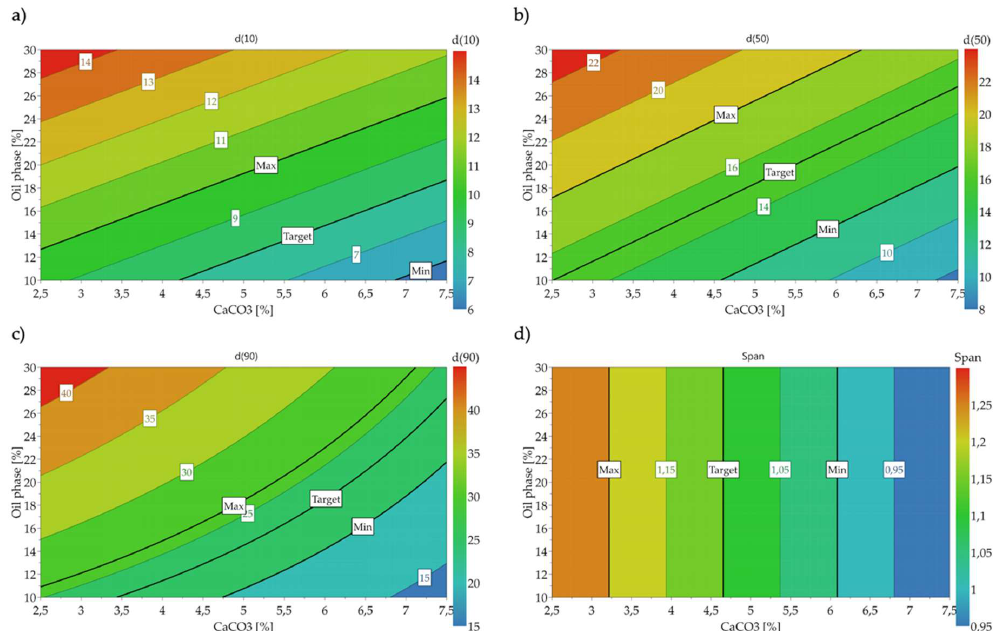
Figure 4. Isoresponse surface plots of relative size distribution (µm), respectively: ( a ) d(10), ( b ) d(50), ( c ) d(90), and ( d ) span for formula optimization. CaCO 3 [%]—% Calcium carbonate particles.